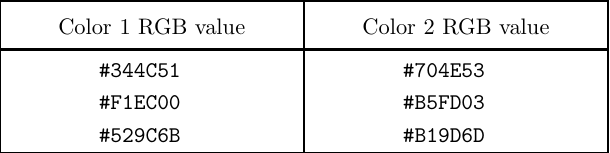
Table 1. Sample color pairs from set used to detect